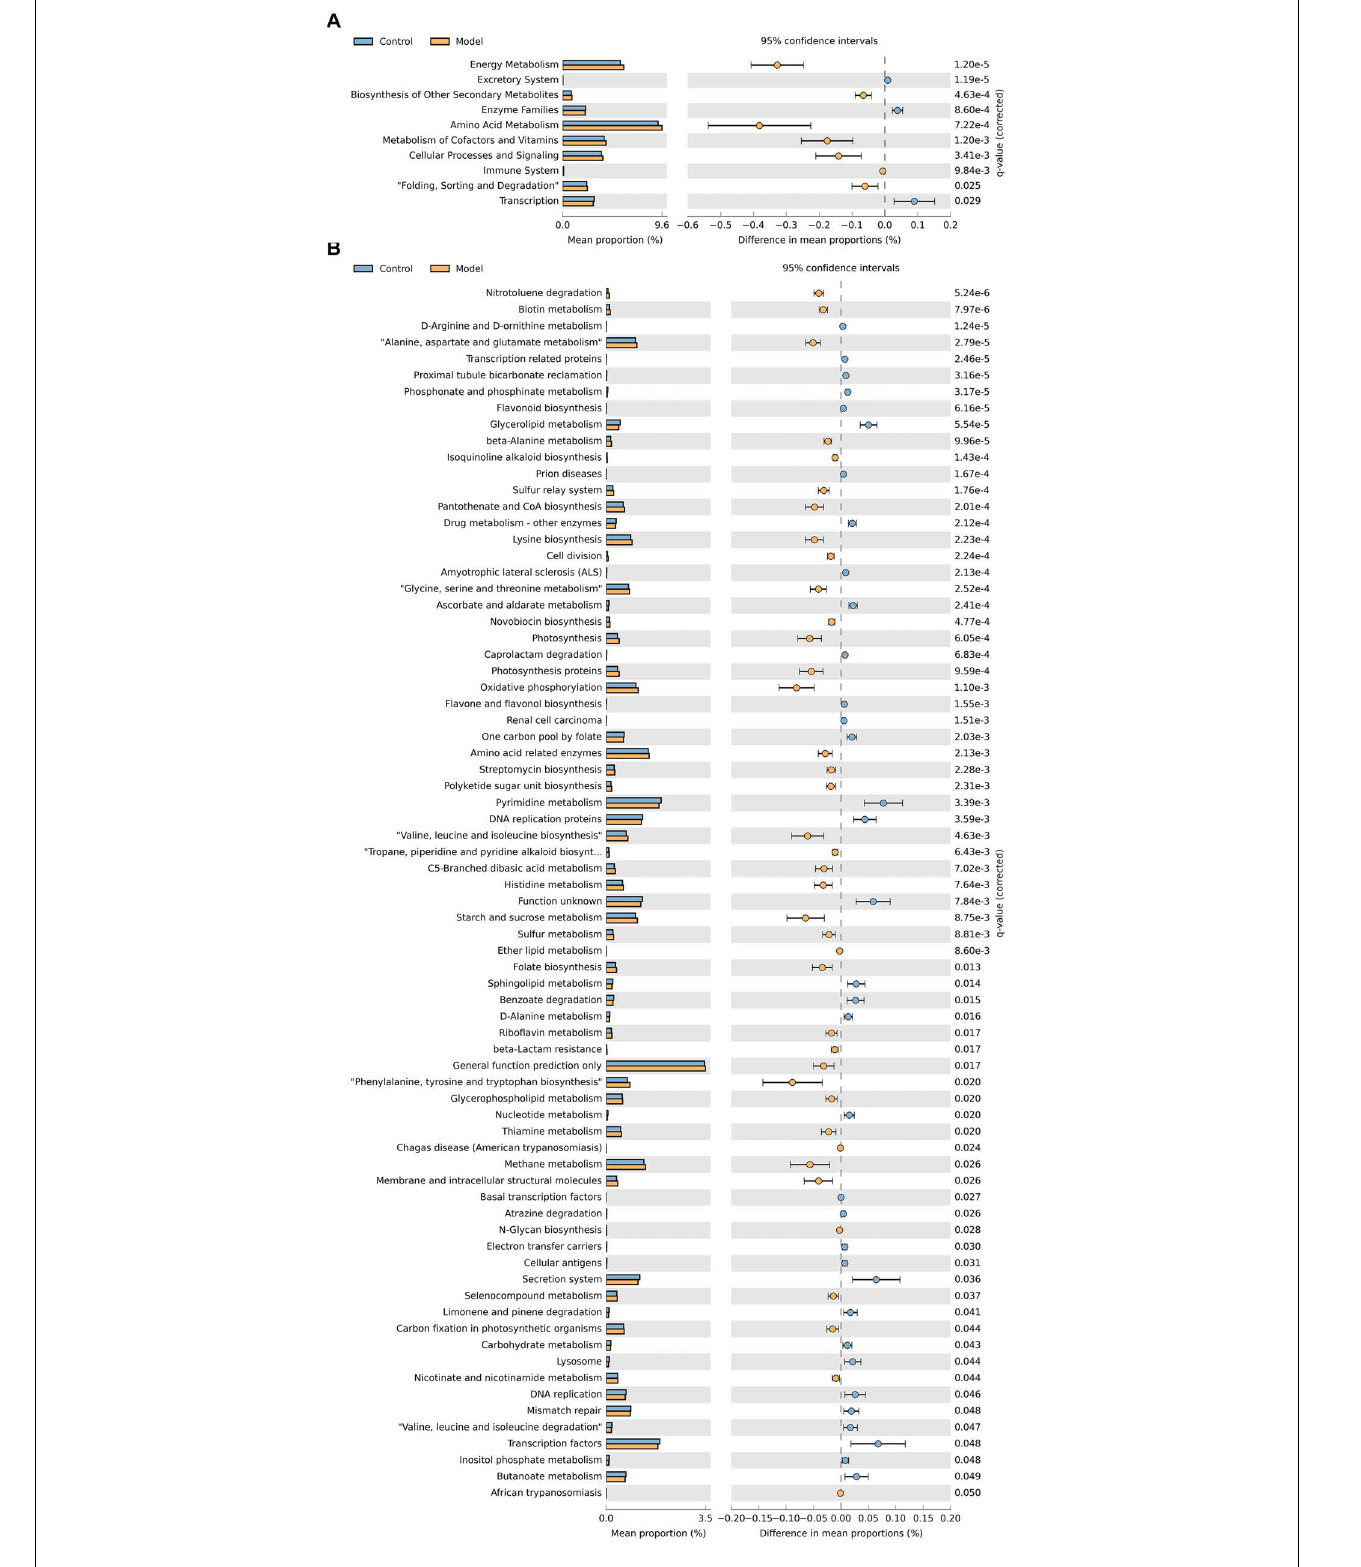
FIGURE 4 | Predicted metabolic functions of cecum microbiota in the control and antibiotic-only groups. Second-level (A) and third-level (B) Kyoto Encyclopedia of Genes and Genomes (KEGG) pathways are shown in the extended error bar. p- values are shown on the right.